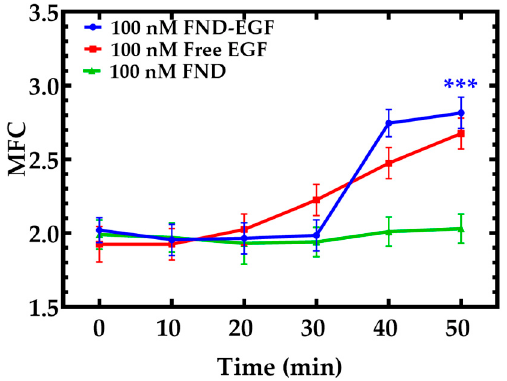
Figure 5. The MFC analysis of A549 cells treated with FNDs, free EGF, and FND-EGF. MFC for cells treated with free EGF showed a moderate increase in MFC (MFC = 2.7 ± 0.1) but there was no change in MFC for cells treated with FND only (MFC = 2.1 ± 0.1). The MFC of cells treated with 100 nM FND for 22 h then later treated with conjugated 100 nM FND-EGF showed a very significant (*** p < 0.01) increase in MFC (2.8 ± 0.2).